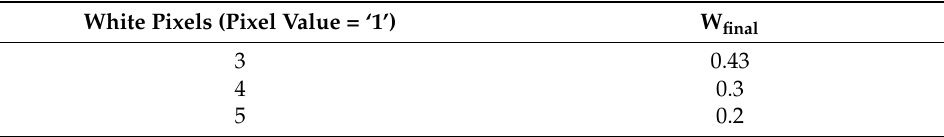
Table 2. Weight value after the weight adjustment. White Pixels (Pixel Value =